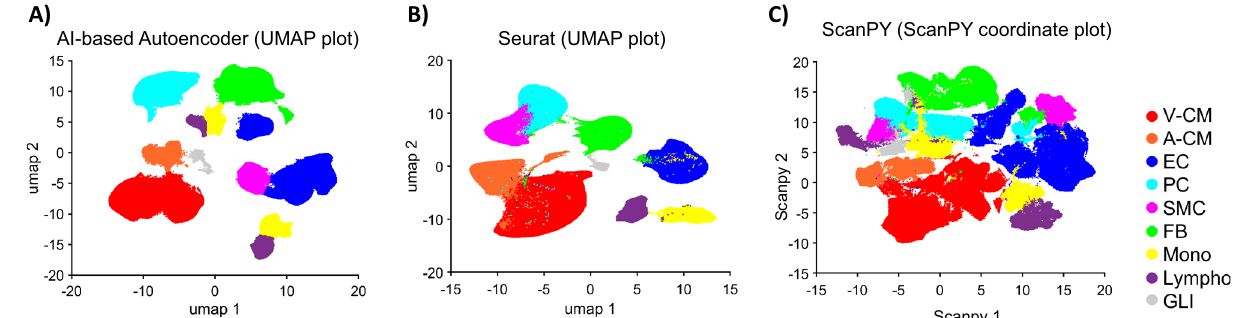
Figure 6. Our proposed pipeline, Seurat, and ScanPY can analyze and identify all major cell types in the human heart cell atlas data. 2D plots visualize the cell clustering and cell-type in ( A ) AI-based Autoencoder (UMAP plot), ( B ) Seurat (UMAP plot), ( C ) ScanPY (ScanPY coordinate plot). V-CM (red): ventricular cardiomyocyte. A-CM (ligh red): atrial cardiomyocyte. EC (blue): endothelial cell. PC (cyan): pericyte. SMC (pink): smooth